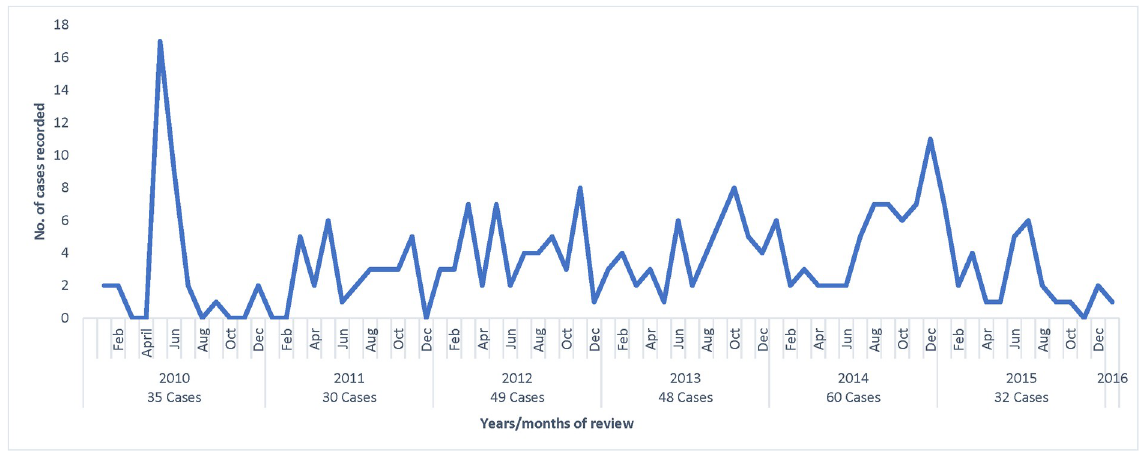
Fig 3. Trends of patients treated for suspected cutaneous leishmaniasis in health facilities in Gilgil between January 2010 and January 2016 (N = 255).